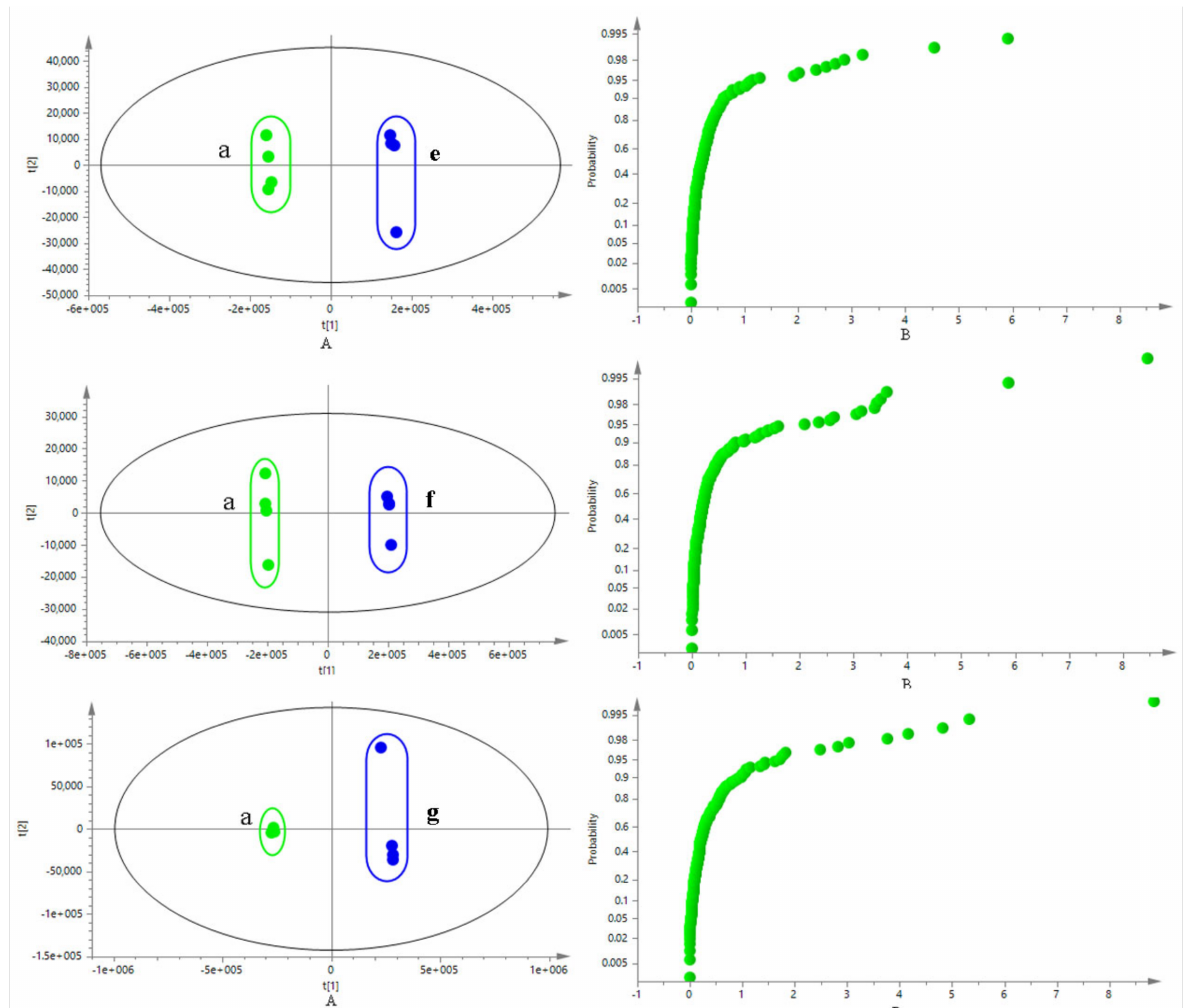
Figure 5. PLS-DA scores plot and VIP score plot of TH samples from different hosts. ( Morus alba L. ( a ), Liquidambar formosana Hance. ( b ), Ilex latifolia Thunb. ( c ), Crataegus pinnatifida Bge. var. major N.E.Br. ( d ), Passiflora edulis Sims. ( e ), Pyrus pyrifolia (Burm. F.) Nakai. ( f ), and Cinnamomum camphora (L.) Presl ( g )).